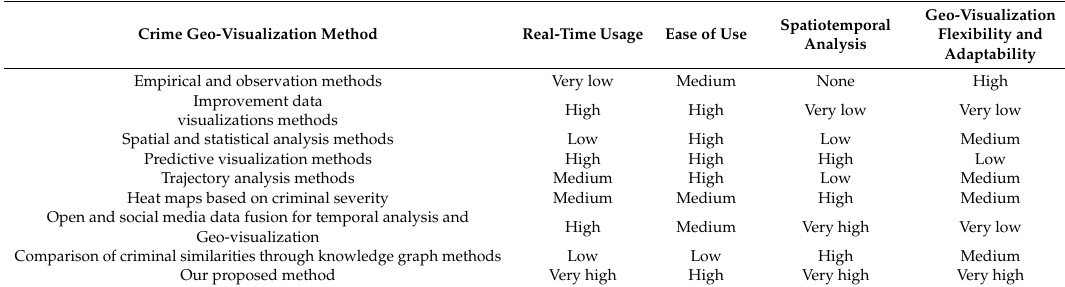
Table 1. Methods and systems for graphical representation of data to visualize criminal activity. Comparison for Command and Control